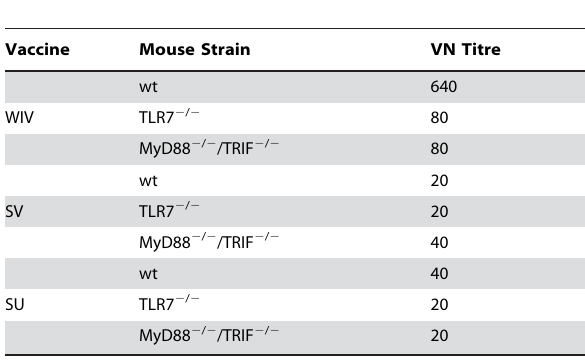
Table 1. TLR-dependent and -independent mechanisms contribute to virus neutralization titres induced by